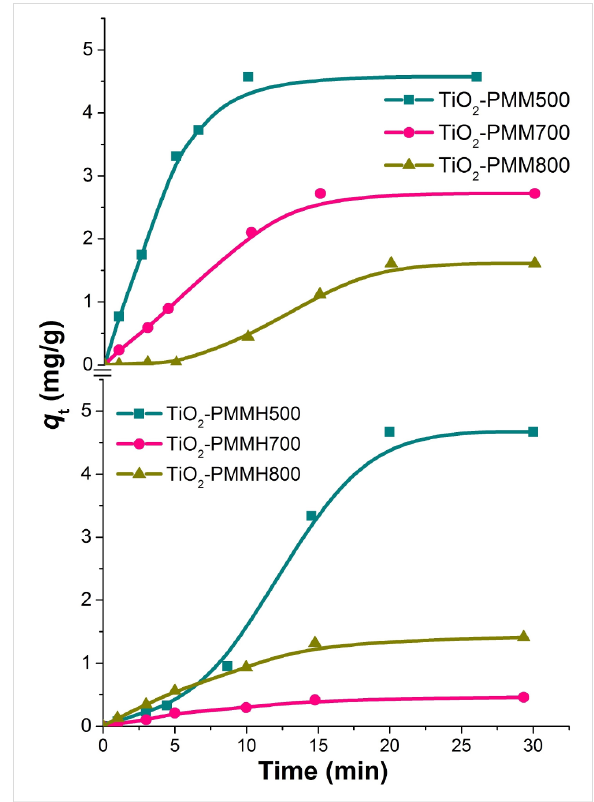
Figure 7: Kinetic curves of methyl orange dye adsorption at 20 °C by the TiO 2 -PMM x , and TiO 2 -PMM Н x samples.